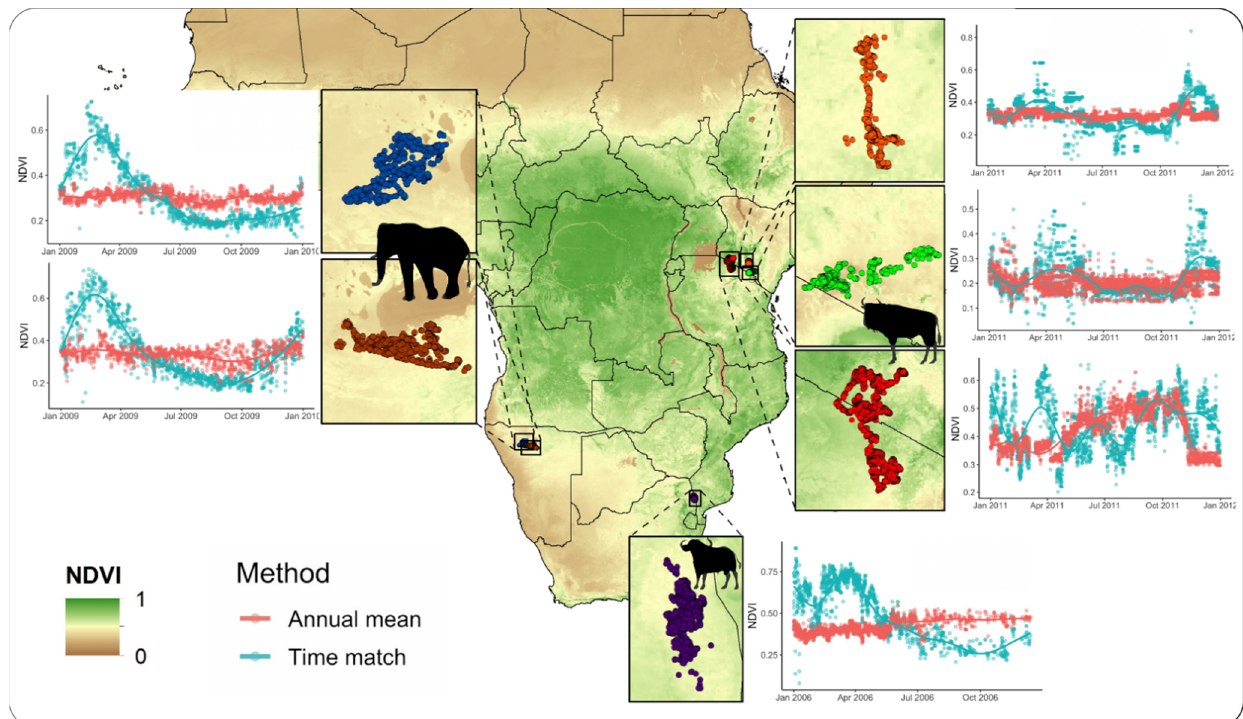
Figure 2. MODIS NDVI values extracted across a year of data for the African buffalo ( Syncerus caffer ), African elephant ( Loxodonta africana ), and blue wildebeest ( Connochaetes taurinus ) tracked with GPS telemetry units. Results show widespread discrepancies between the annual mean NDVI (red) and the time-matched NDVI (blue) extracted at all animal locations across species and regions.